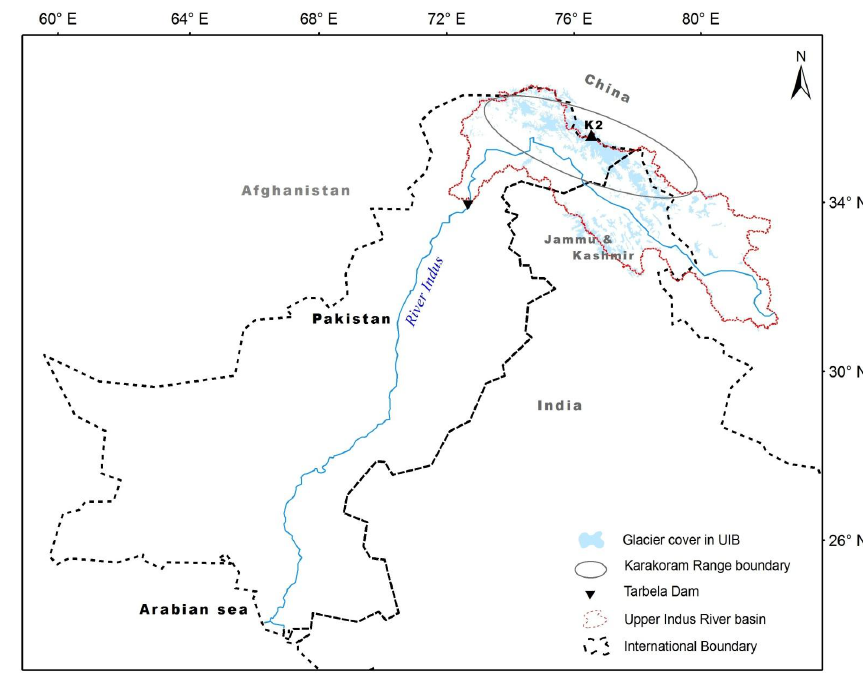
Fig. 1 Location of the Upper Indus River Basin (UIB) with main controlling storage at Tarbela Dam.